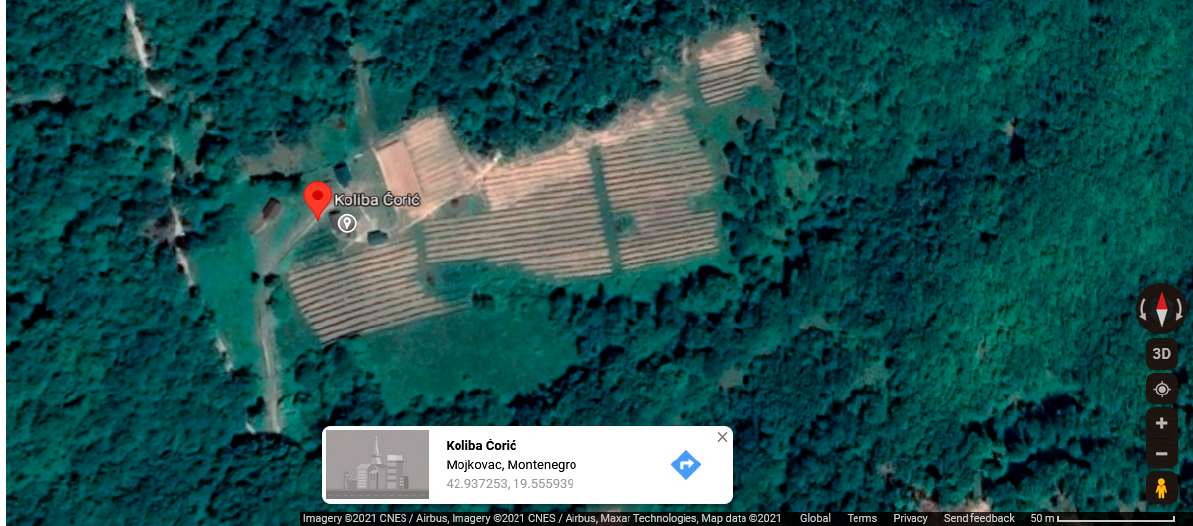
Figure 3. Position of the study area in Podbisce, Mojkovac, Montenegro (42°56 ′ 14.5 ″ N 19°33 ′ 22.4 ″ E; 42.937360, 19.556216), source Google maps.